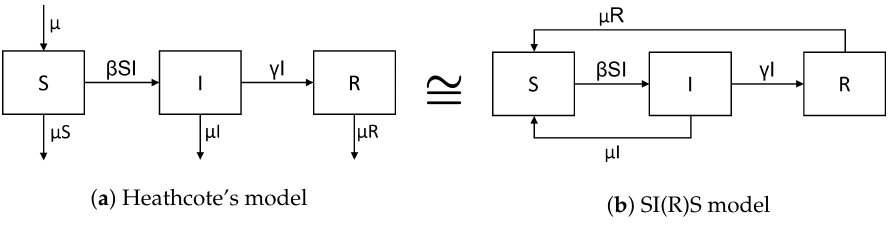
Figure 3. Equivalence of models using µ − µ S = µ I + µ R